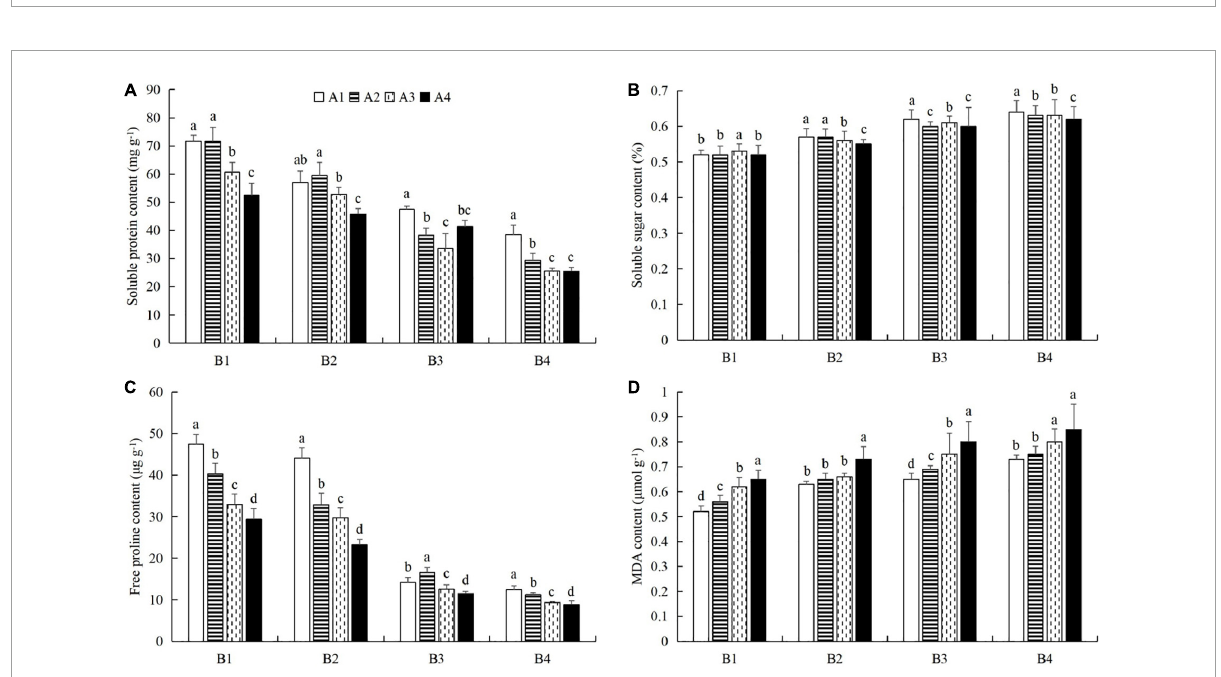
FIGURE12 The effects of azoxystrobin on the contents of (A) soluble proteins, (B) soluble sugars, (C) free proline, and (D) malondialdehyde (MDA) in cucumber leaves at different imidacloprid concentrations. Azoxystrobin concentrations: 4 mg L − 1 (A1), 2 mg L − 1 (A2), 1 mg L − 1 (A3), and 0 mg L − 1 (A4). Imidacloprid concentrations: 750 mg L − 1 (B1), 500 mg L − 1 (B2), 250 mg L − 1 (B3), and 0 mg L − 1 (A4). The mean value ± p < 0.05 error bar data were presented in the figure and different alphabetical letters indicate the significant differences between the different azoxystrobin